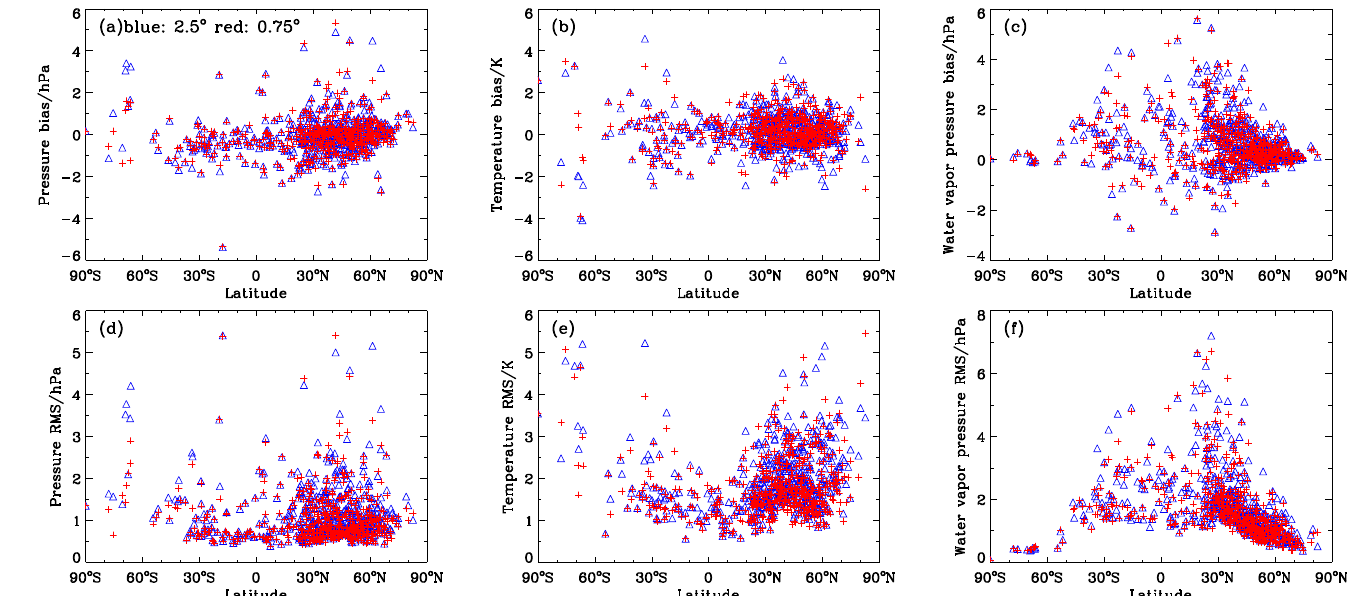
Figure 2. Distribution of station-wise bias ( a, b, c ) and RMS ( d, e, f ) values of pressures, temperatures, and water vapor pressures derived from ERA surface analysis data (blue: 2.5° × 2.5°; red: 0.75° × 0.75°) at 530 IGRA stations in 2015.